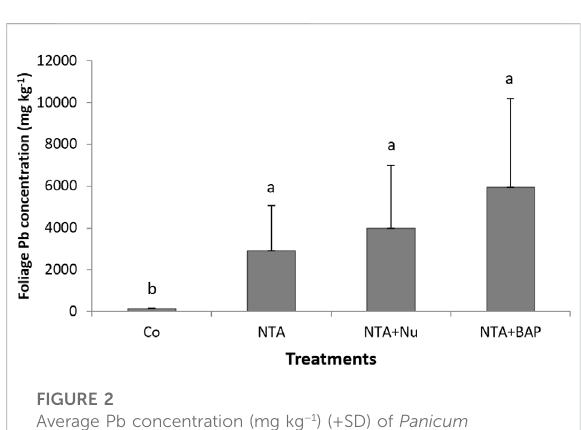
FIGURE 2 Average Pb concentration (mg kg − 1 ) (+SD) of Panicum virgatum in different treatments. Treatments: NTA — 10 mM NTA, Nu — foliar nutrients application of Triple-12 ® , BAP- Promalin